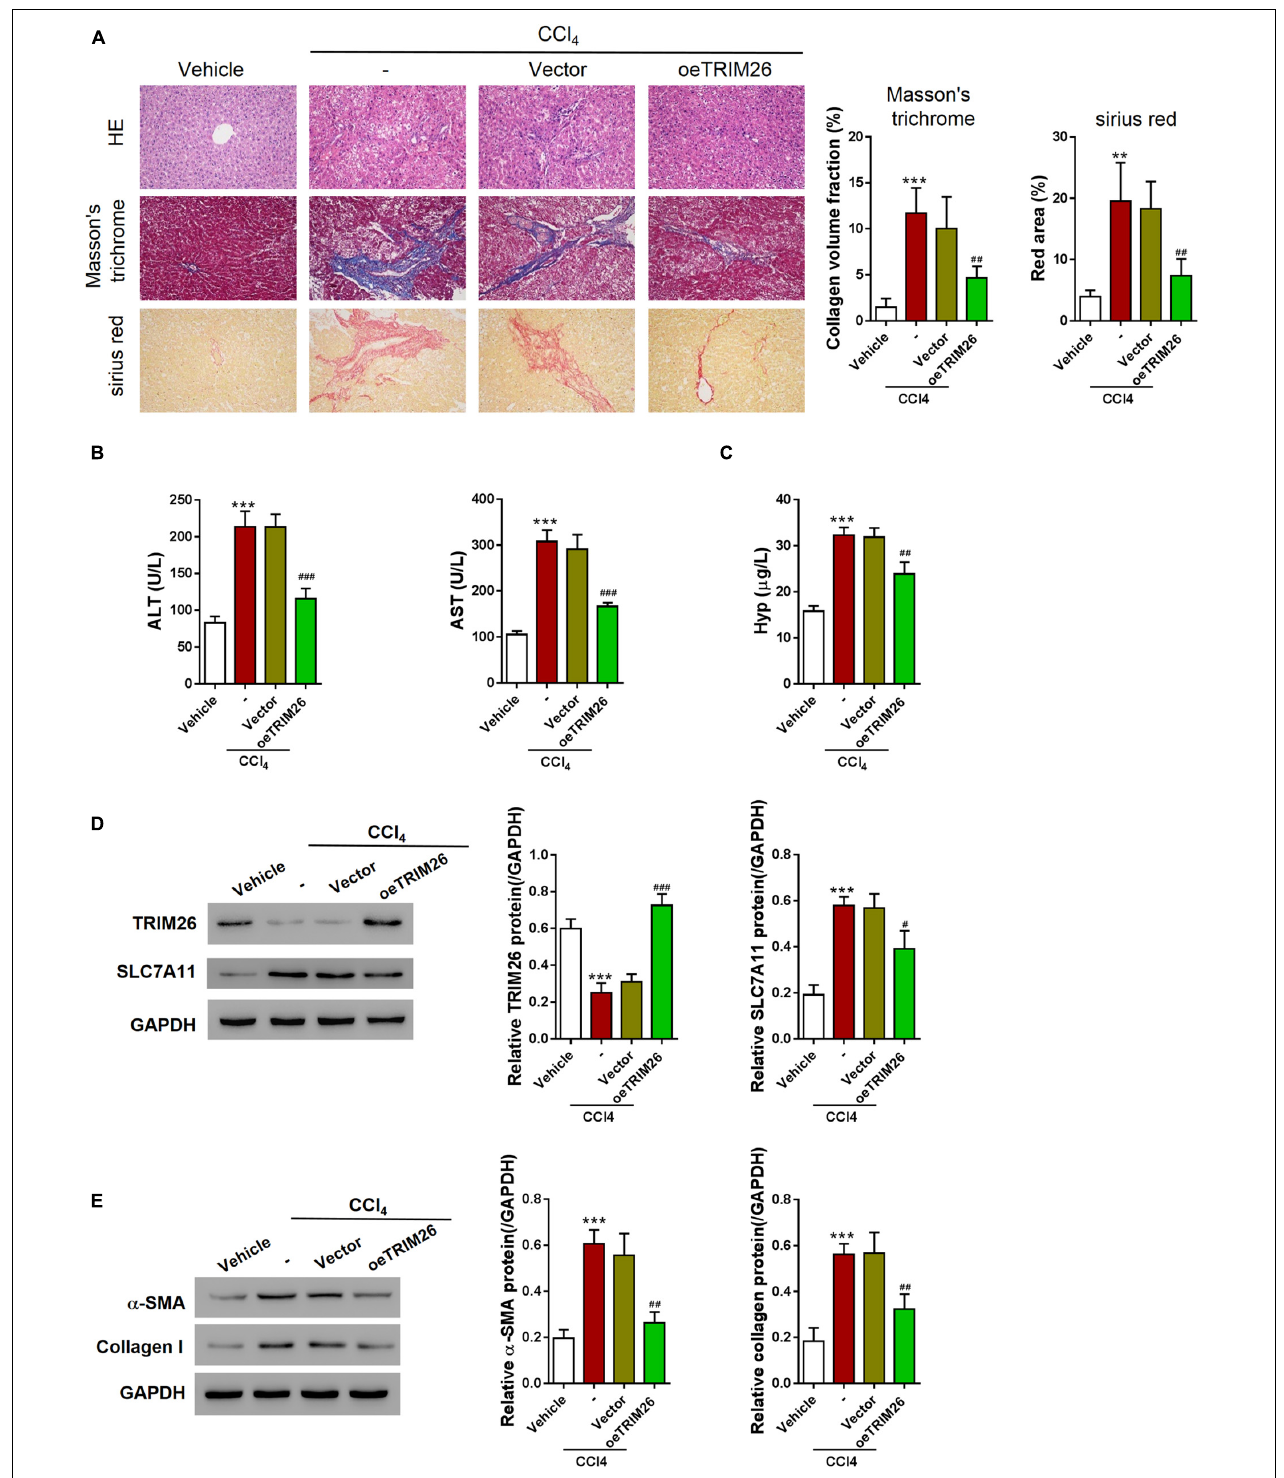
FIGURE 6 | In vivo effect of TRIM26 overexpression on CCl 4 -induced liver fibrosis. Mice liver fibrosis model was established by CCl 4 induction. Recombinant adenovirus Vector or oe TRIM26 was injected into the mice through tail vein. (A) Histological examination (magnification at 200 × ) of liver tissues by hematoxylin and eosin, Masson’s trichrome, and Sirius red staining. (B) The serum levels of alanine transaminase (ALT) and aspartate transaminase (AST). (C) The serum levels of hydroxyproline (Hyp). (D) Proteins expressions of TRIM26 and SLC7A11 in liver tissues. (E) Protein expressions of α -SMA and collagen I in liver tissues. ** p < 0.01; *** P < 0.001 vs. Vehicle; # P < 0.05, ## P < 0.01, and ### P < 0.001 vs. CCl 4 + Vector.